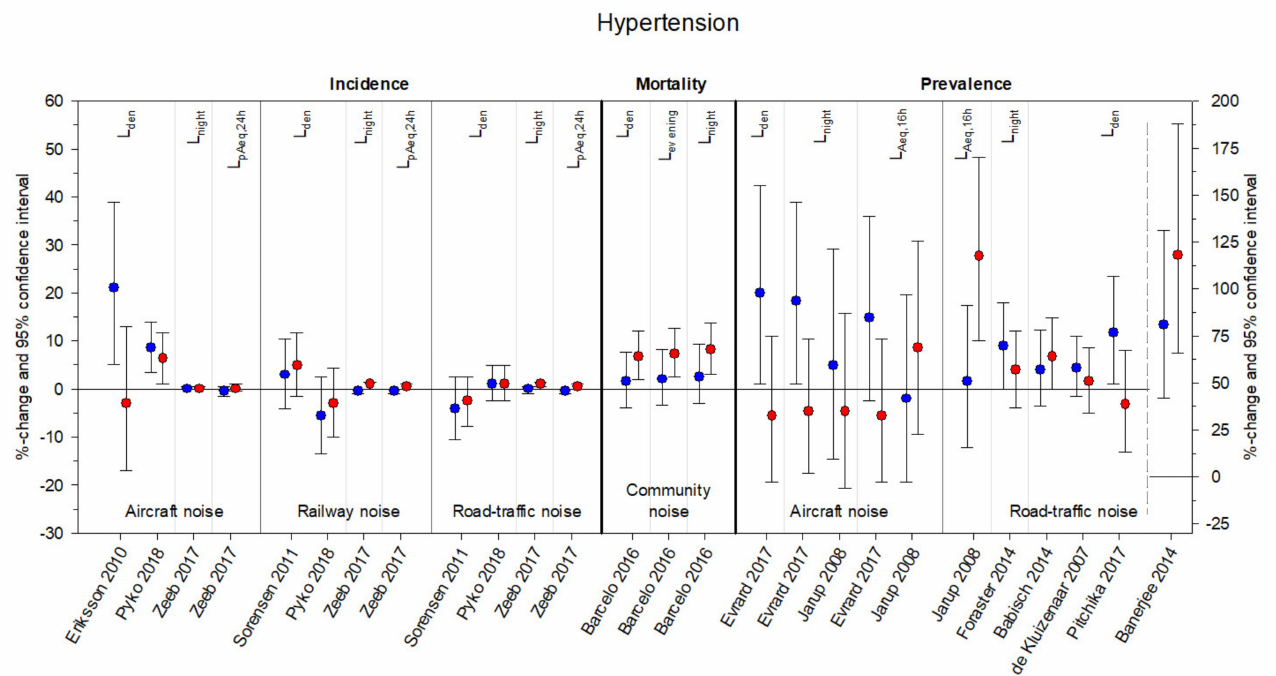
Figure 3. Sex/gender-specific effect estimates from studies with the cardiovascular outcome hypertension. Effect estimates are displayed as percent changes (blue = males, red = females) and 95% confidence intervals per 5 dB(A) increase in noise exposure (aircraft noise, railway noise, road traffic noise, community noise) and grouped according to frequency measure (incidence, mortality, prevalence) and noise indicator (L den , L evening , L night , Lp Aeq, L Aeq, 16 h ). Please note, some studies provided several estimates for different noise indicators per noise exposure and frequency measure. The scale on the right side of the figure only applies to Banerjee 2014.